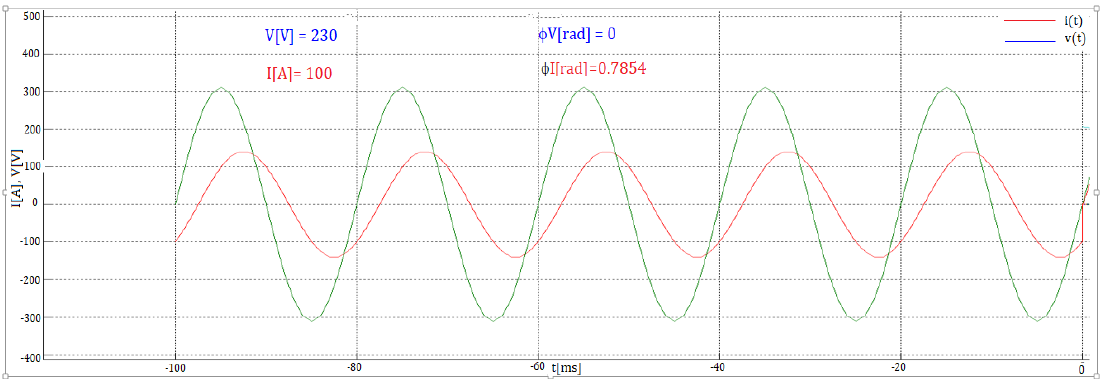
Figure 5. Voltage and current variation for the time interval t ∈ ( − 100,0) ms. The program developed in Matlab aims to connect/disconnect a switch with the SF6 extinguishing medium in the case of a transient regime. To do this, the ideal disconnec- tion/connection time pattern is used, as in Figure 6, at disconnection, and in Figure 7 during the connection